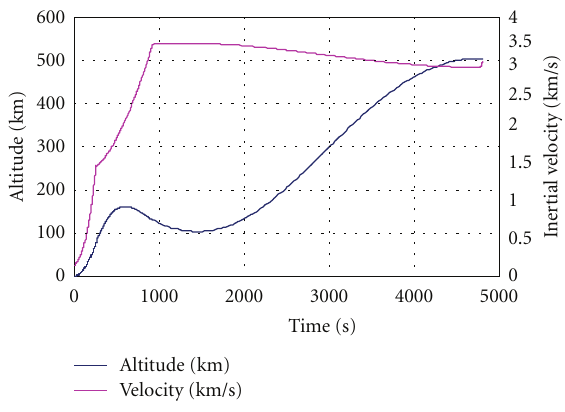
Figure 4: Typical Mars ascent trajectory [6].